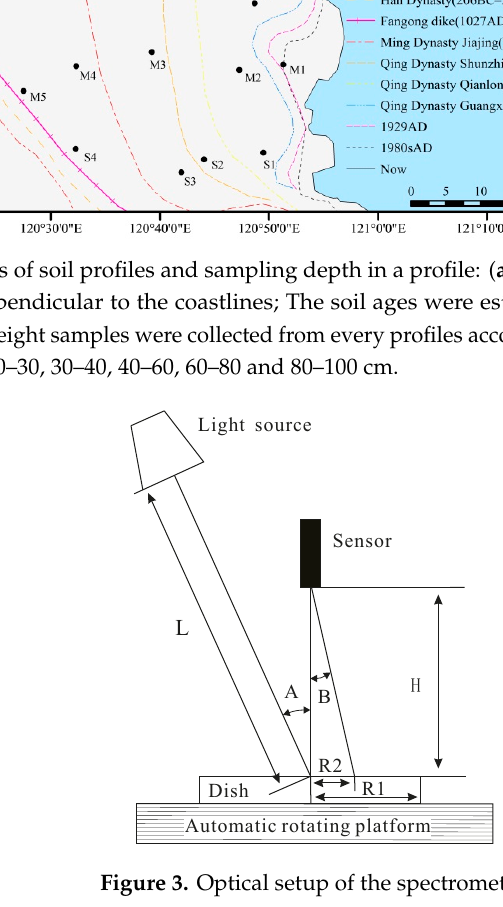
Figure 3. Optical setup of the spectrometer.